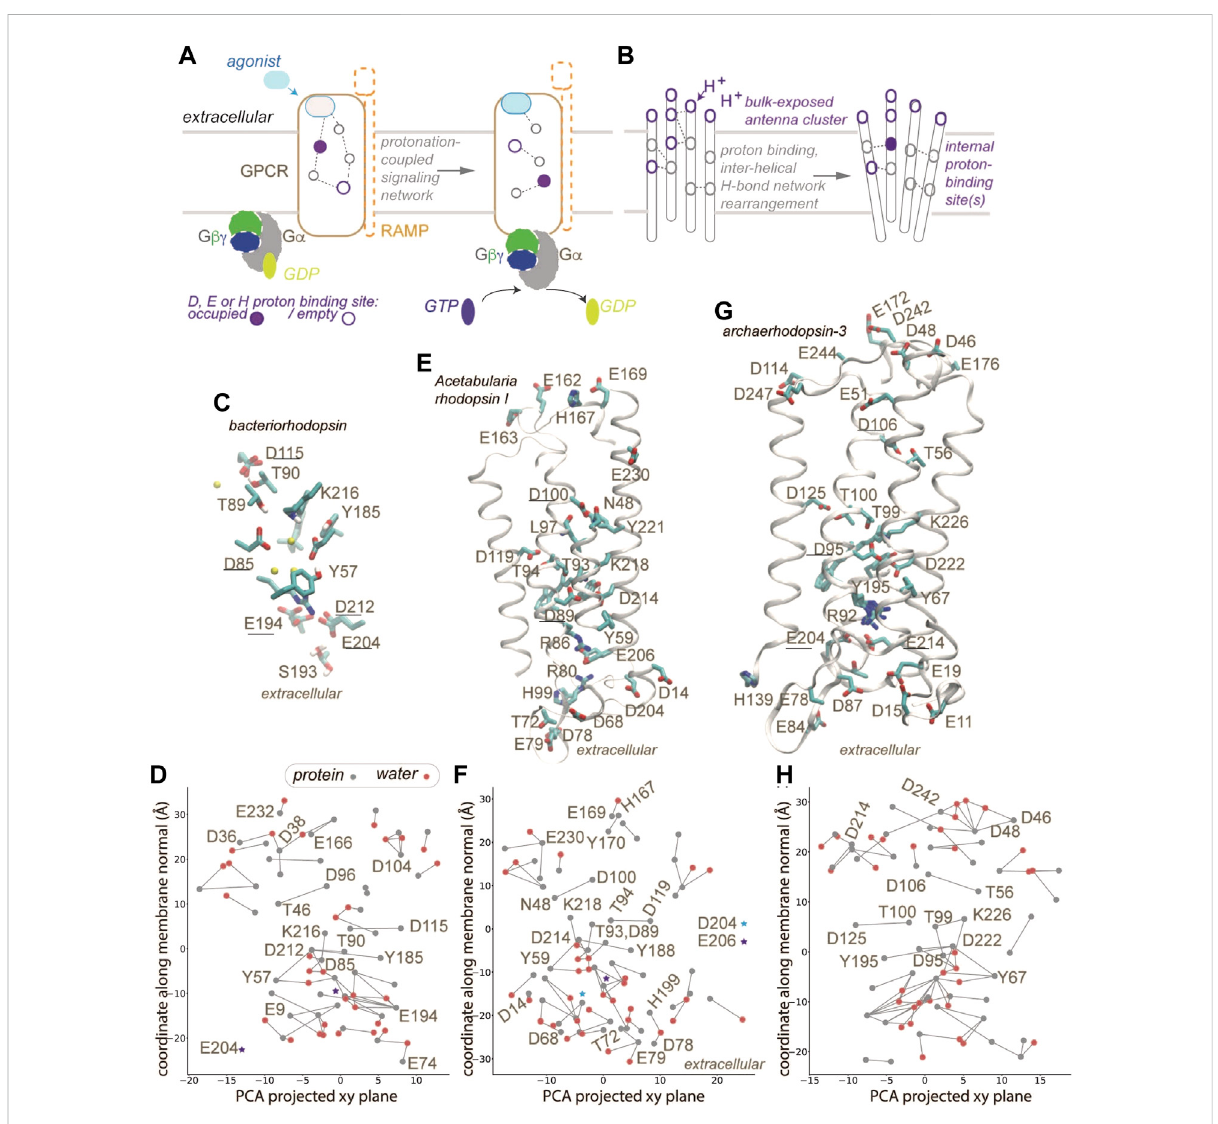
FIGURE 1 GPCR activation and protonation-coupled conformational dynamics with H-bond networks. (A) Agonist and G-protein binding may associate with protonation-coupled formation of acontinuous H-bond network inside theGPCR. (B) Schematicrepresentation of amembrane protein with a bulk-exposedprotonantennaclusterandaninternalproton-bindingsite. (C,D) CloseviewoftheinternalH-bondnetwork (C) andH-bondgraph (D) computed for bacteriorhodopsin, pdb 7z09 [39]. Gray and red nodes represent, respectively, protein sidechains and water oxygen atoms; only selectednodesarelabeled. (E,F) Moleculargraphics (E) andH-bondgraph (F) computedfor Acetabularia rhodopsinI,pdb5awz[40]. (G,H) Molecular graphics (G) andH-bondgraphcomputedforarchaeorhodopsin-3,pdb6gux[41].OnlysomehelicesaredisplayedinpanelsE,G.Groupsunderlined in panels C,E,G were implicated in proton binding [40, 41, 78]. Molecular graphics included in Figure 1 and Figure 2 were prepared with Visual Molecular Dynamics, VMD [79]. H-bond graphs in panels D, E, H were computed with C-Graphs [19] using structures aligned with OPM